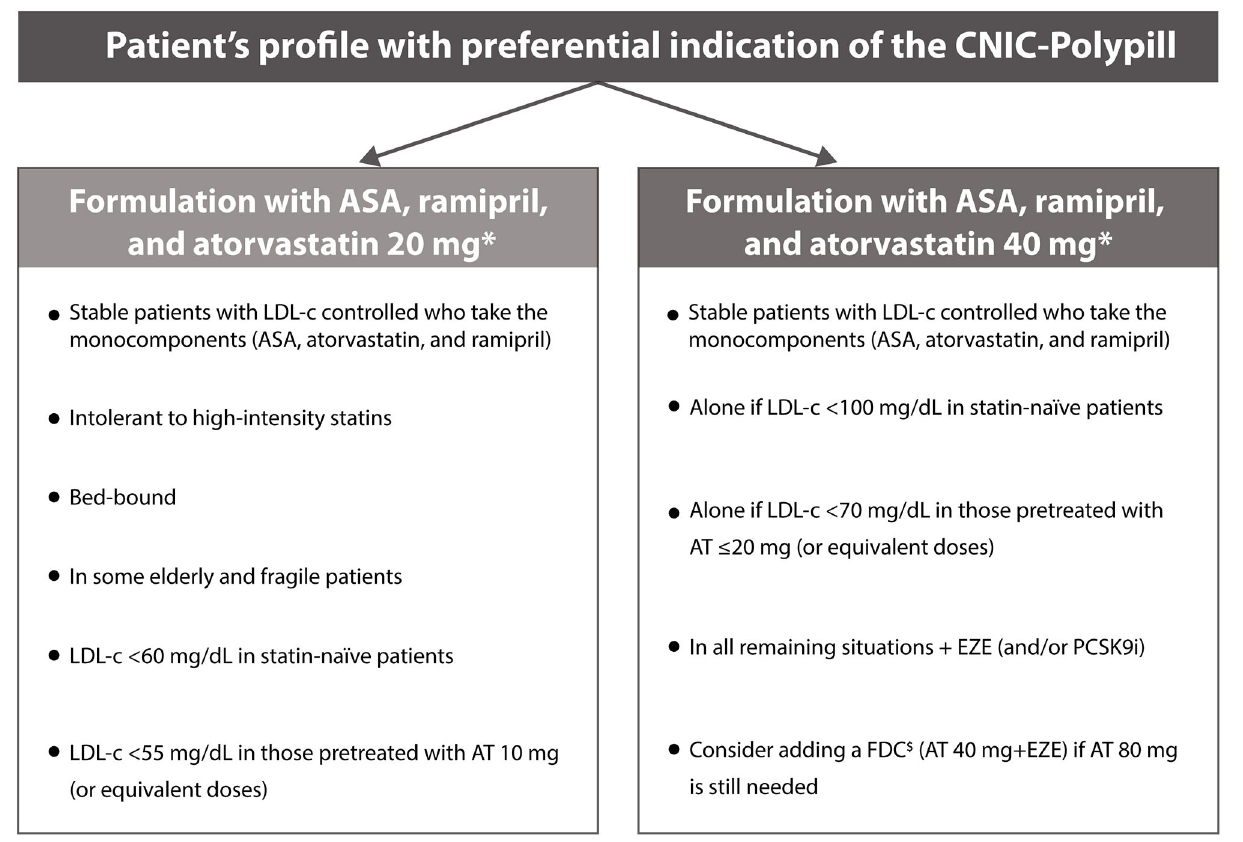
FIGURE 4 | Summary of the adequate profile of patients who are considered candidates to switch to the CNIC-Polypill. Note: *Or equivalent doses of the monocomponents. $ Use only if the patient does not develop side effects to atorvastatin 80mg (or equivalent doses of another statin). ACS, acute coronary syndrome; AT, atorvastatin; CV, cardiovascular; EZE, ezetimibe; FDC, fixed-dose combination; LDL-c, low-density lipoprotein cholesterol; PCSK9i, proprotein convertase subtilisin/kexin type 9